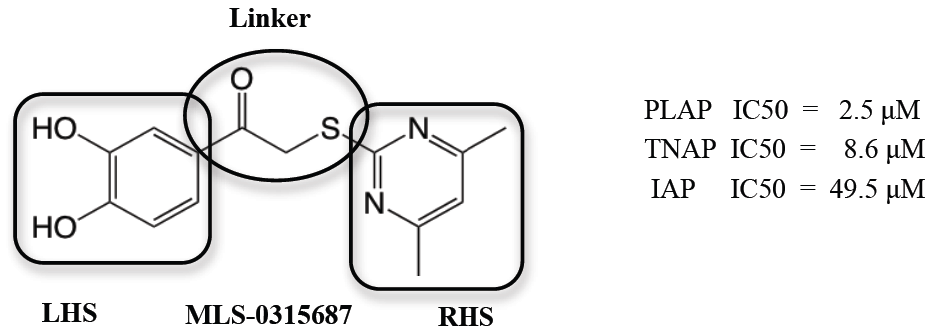
Figure 9. Depiction of the three regions of MLS-0315687 for SAR: Left Hand Side (LHS), Right Hand Side (RHS) and Linker region